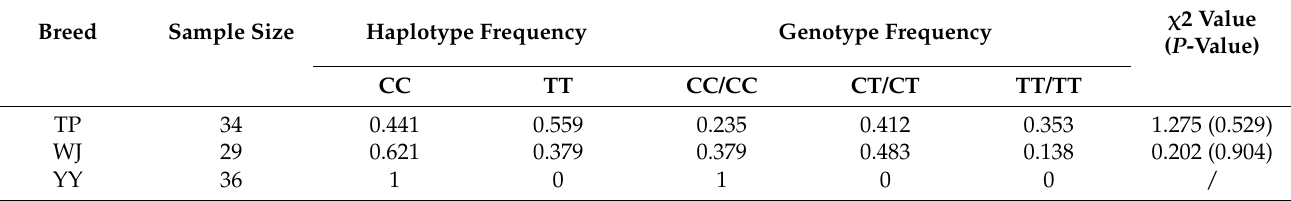
Figure 2. SNP sites and promoter activity analysis. ( A ) The sequencing chromatogram at the sites of two SNPs, C-1604T and C-1763T. The arrows indicate the SNP site. ( B ) Dual-luciferase analysis for promoter activity. Control refers to C2C12 cells co-transfected with PGL3-basic and PRL-TK. CC and TT represent CC and TT homozygous individuals whose promoters are connected to PGL3-basic and co-transfected with PRL-TK cells, respectively. Each bar represents the mean ± SD. ** P < 0.01. Table 1. Genotype and haplotype frequencies in the C-1763T and C-1604T in pig populations. Table 2. Analysis of the effects of CC, CT, and TT genotypes of the TRPC1 gene in New Huai pigs. Breed Sample Size Days to: